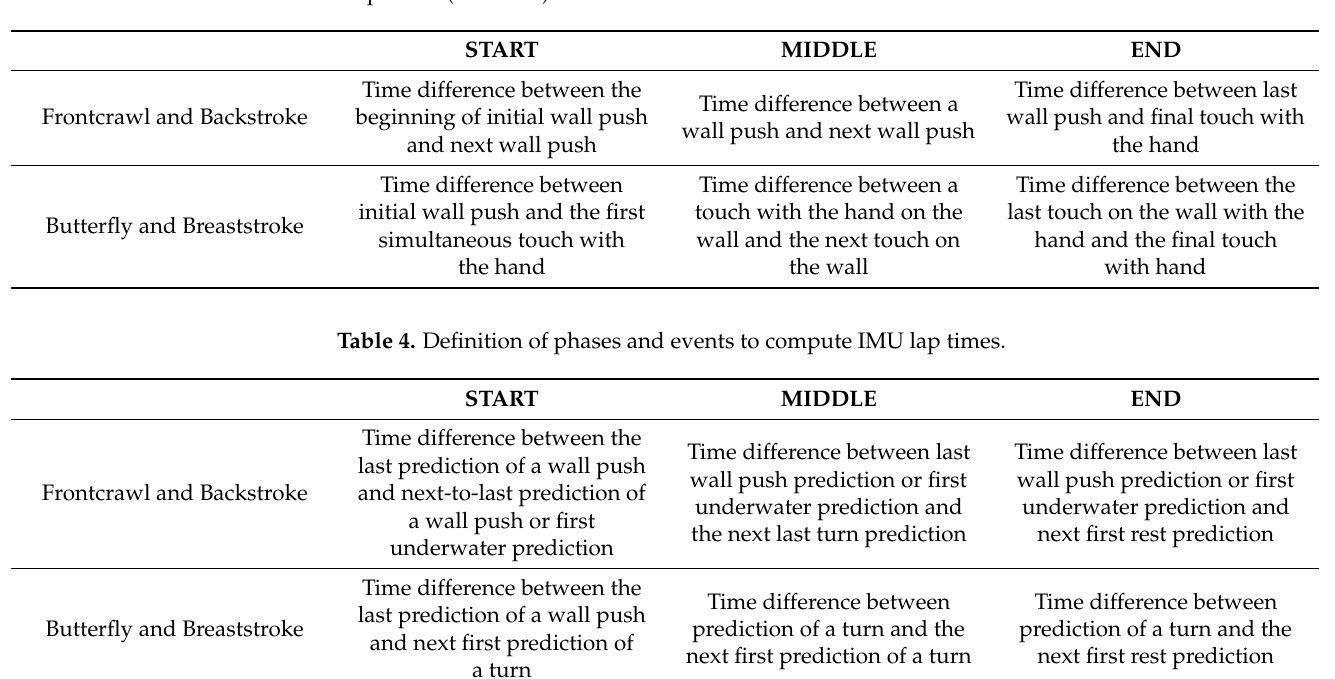
Table 3. Definition of phase and events to compute LT CAM and to monitor swimmer activity with